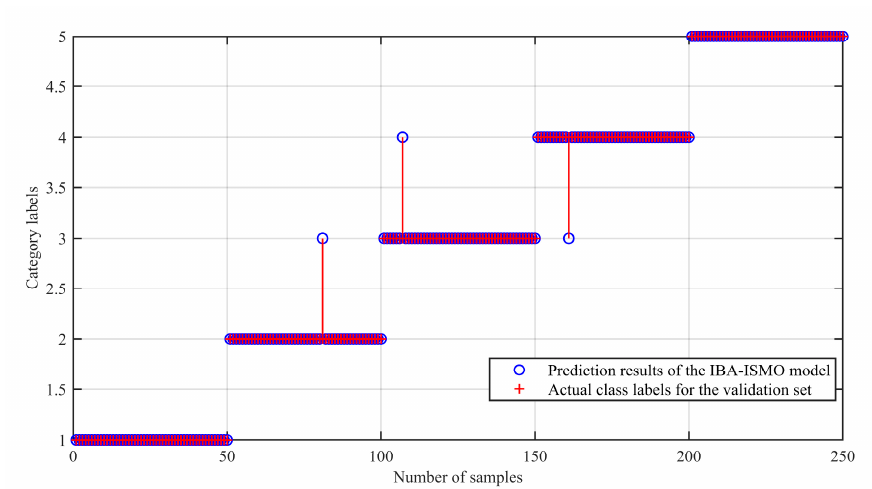
Figure 11. IBA-SMO Model verification.